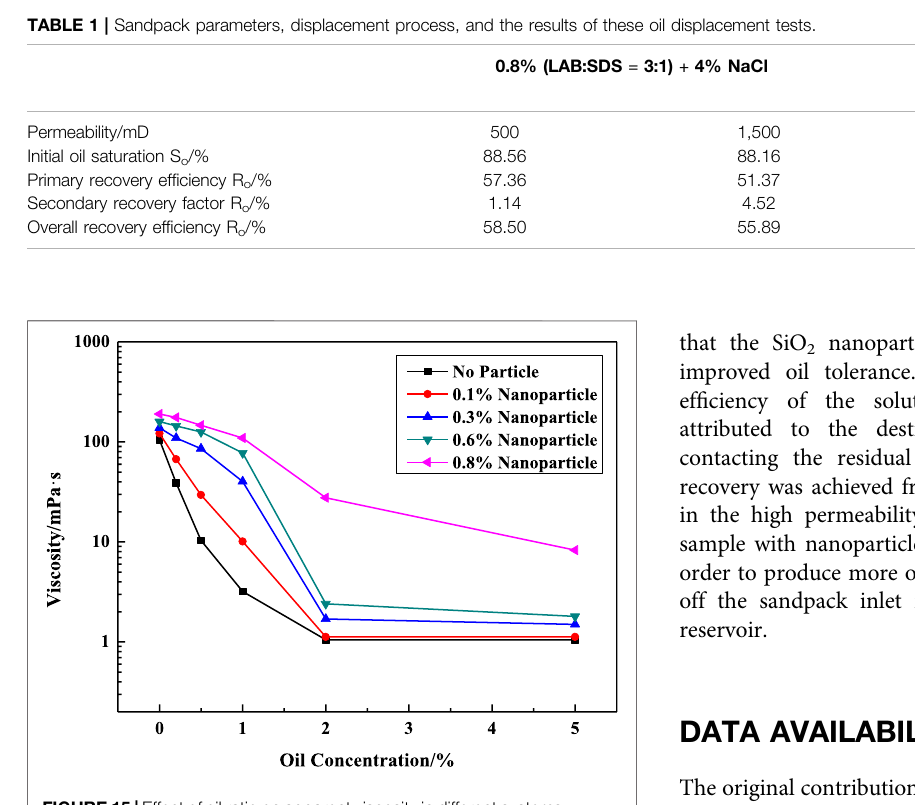
FIGURE 15 | Effect of oil ratio on apparent viscosity in different systems. ( w (LBA + SDS) (cid:2) 0.8%, LBA:SDS (cid:2) 3:1, T (cid:2) 50 ° C, w (NaCl) (cid:2) 4%, γ (cid:2) 7.34s − 1